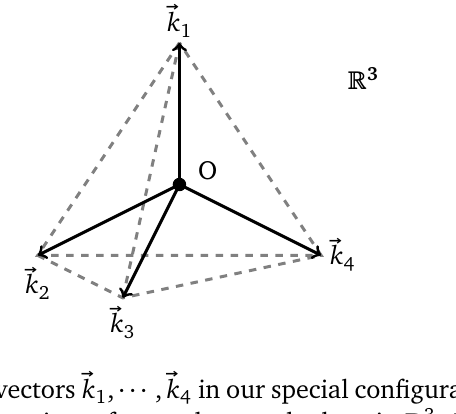
(cid:126) (cid:126) k k Figure 2.3: Momentum vectors , ··· , in our special configuration for N = 4 (and 1 4 hence d = 5) form four vertices of a regular tetrahedron in (cid:82) 3 . For higher values of N, they will similarly construct a regular ( N − 1 ) -simplex in (cid:82) N − 1 with the equal angle ) in between cos − 1 ( − 1 N − 1